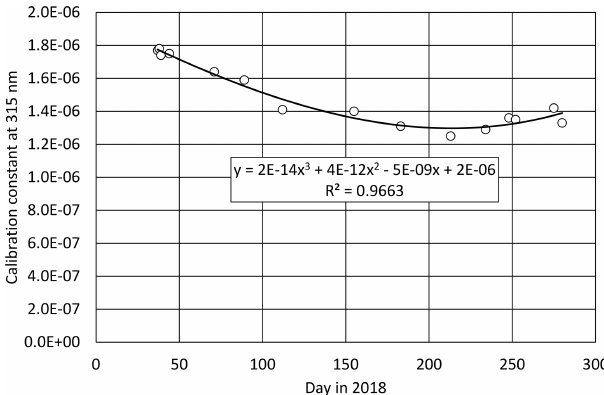
Figure A1. Estimated calibration constant at 315nm and the fitting line by the polynomial regression. R2 is the coefficient of determi-